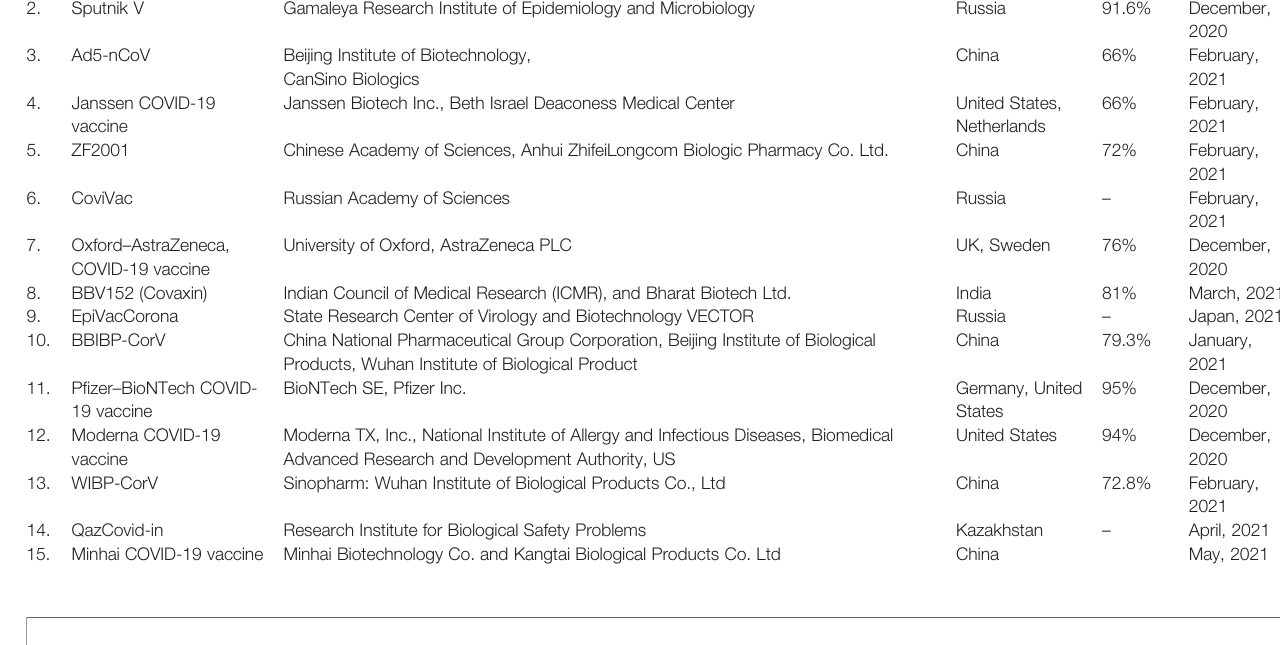
TABLE 4 | Approved COVID-19 vaccines and their developers, country of origin, ef fi cacy, and approval month. Sl. no